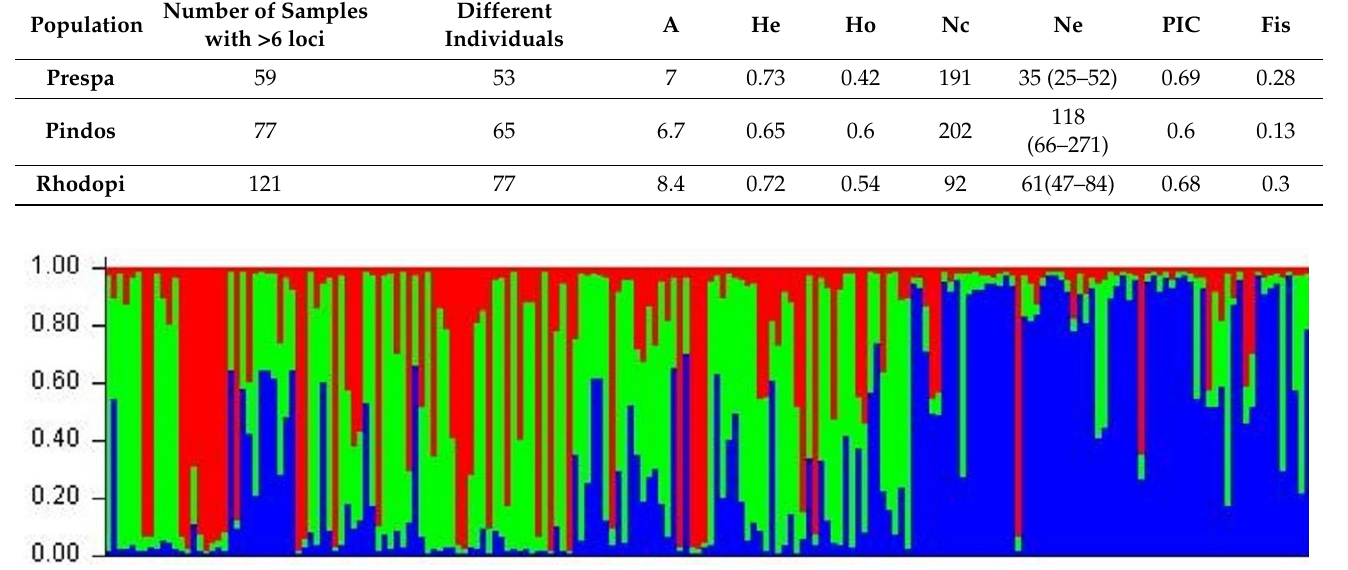
Figure 7. STRUCTURE results for the 3 sub-populations of brown bears: each individual is repre- sented by a vertical line broken into 3 coloured segments, with lengths proportional to each of the 3 membership probabilities. With green we denote the Prespa population, with blue the Pindos pop- ulation, and with red the Rhodopi population. Table 8. Average estimates of number of alleles (A), expected heterozygosity (He), observed heter- ozygosity (Ho), census population size (N C ), effective population size (Ne), polymorphic infor- mation content (PIC), and inbreeding coefficient (Fis) in the three project areas.